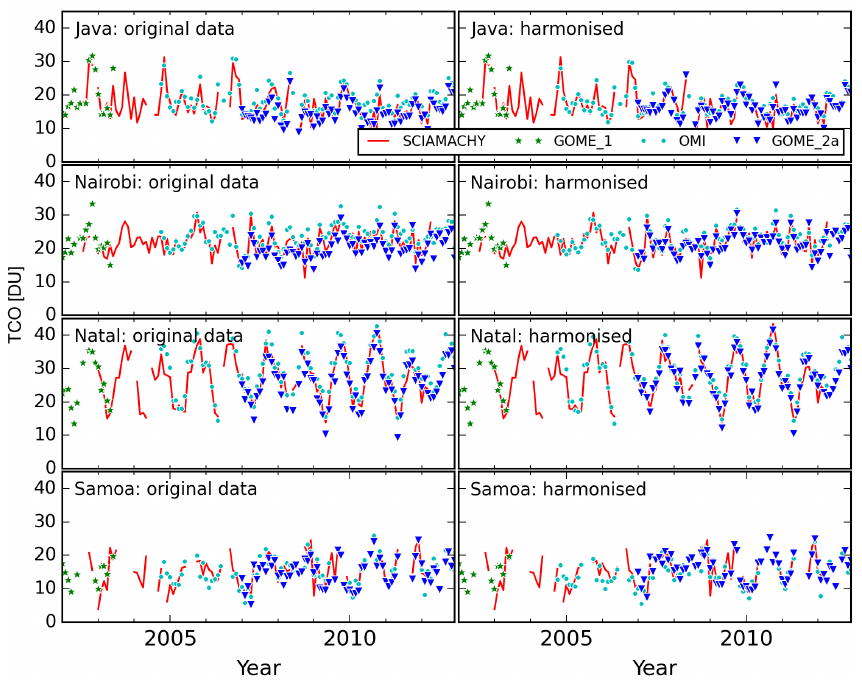
Figure 4. Time series of TCO from SCIAMACHY as well as GOME, OMI and GOME-2A for SCIAMACHY lifetime at four selected sounding stations. Both the OMI and the GOME-2A data clearly deviate from the SCIAMACHY data in the original data (left), the deviation is reduced in the harmonised data